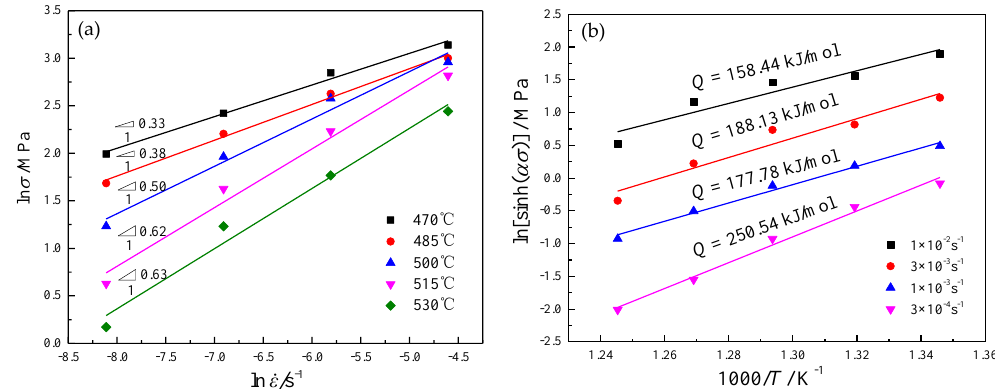
. ε ( b ) the calculation of thermal activation